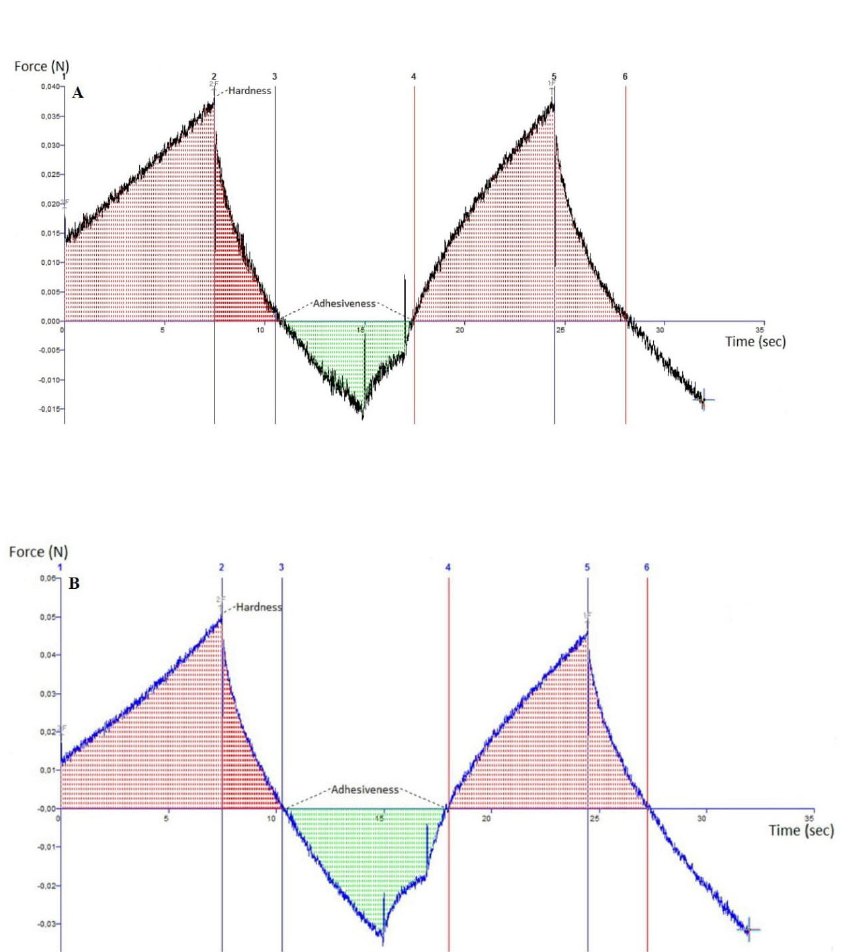
FIGURE 4 - Texture profile analysis graphs of hydrogel formulations (a: A2, b: F2). All of the formulations have texture profile analysis graphs but A2 and F2 formulations were selected because these formulations were optimized in terms of mechanical properties. The first peak of the graphs expresses the hardness value. The area under the curve between 3 and 4 (AUC3-4) is calculated as the adhesion